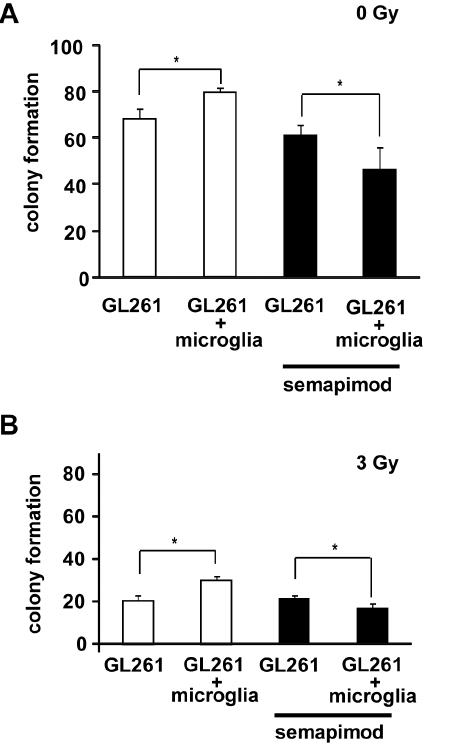
Figure 2. Semapimod removes microglia-induced radioprotec- tion on GL261 invitro . GL261 cells were cultured in the presence or absence of microglia and in the presence or absence of 200 nM of semapimod, followed by a colony formation assay. (A) Colony formation assay of GL261 after treatment with microglia and semapimod. (B) Determination of survival of GL261 after treatment with 3 Gy irradiation, microglia and semapimod. Data shown represent the average + / 2 SEM of 3 independent experiments. *: p , 0.05 student’s 2 tailed t-test.